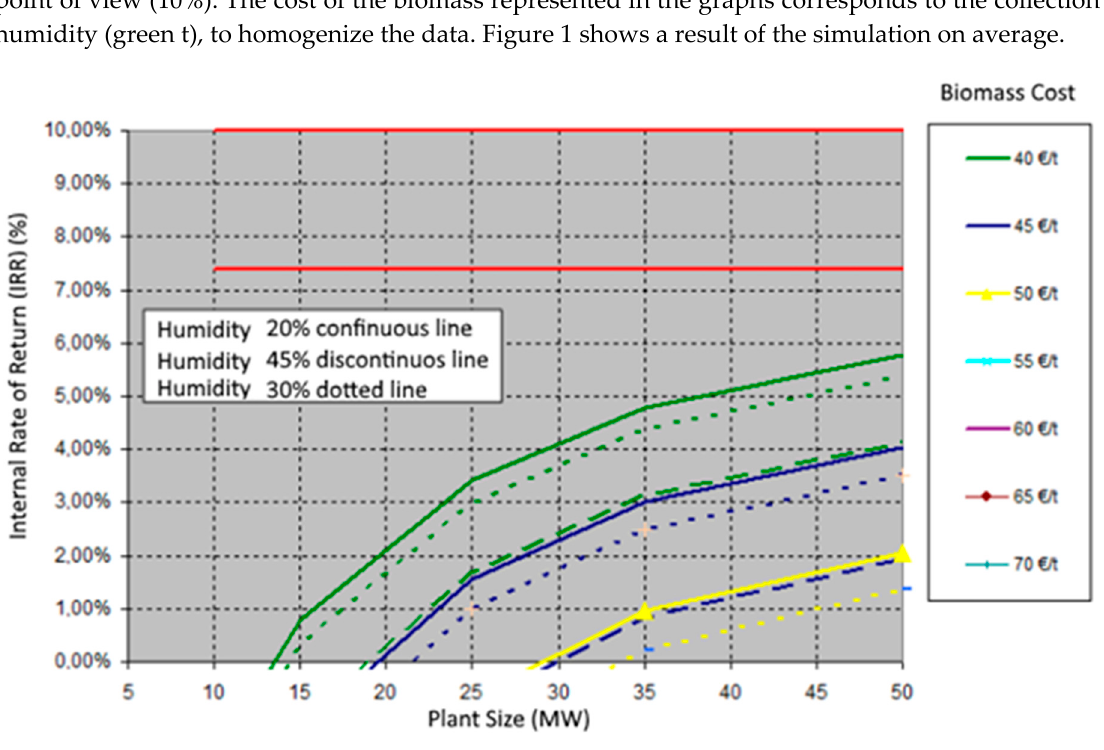
Figure 1. Example of the simulation results of the energy